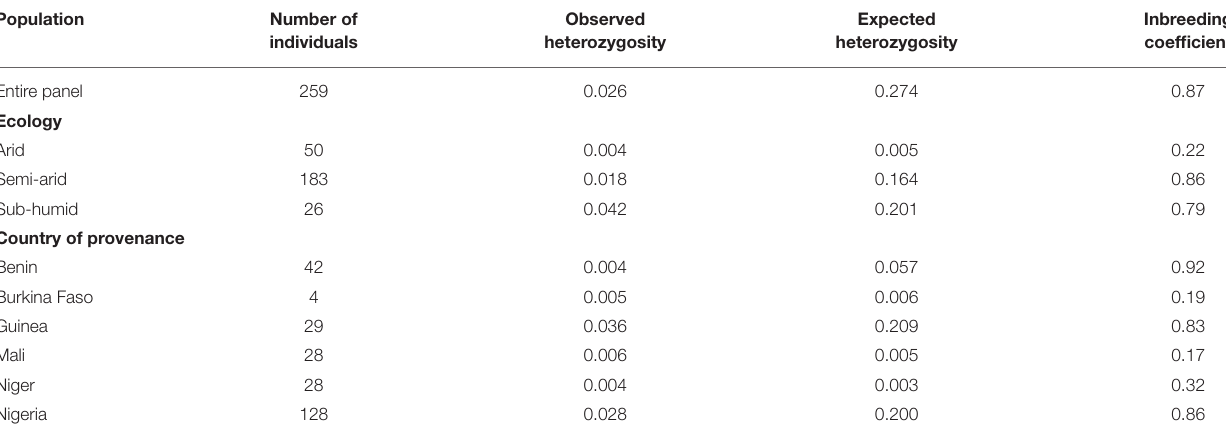
TABLE 3 | Genetic diversity estimations of 259 fonio accessions based on ecological regions and country of provenance.